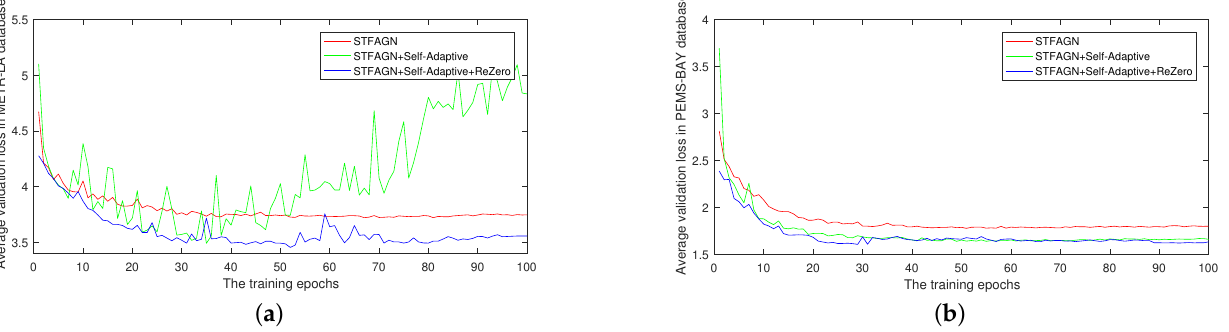
Figure 3. Comparison of the average validation loss of five results in STFAGN with different configurations in ( a ) METR-LA and ( b ) PEMS-BAY. Table 3. Ablation experiments on different configurations of modules in METR-LA and PEMS-BAY datasets. The default configuration we use in STFAGN is times to get five results then calculated the mean and standard deviation of the